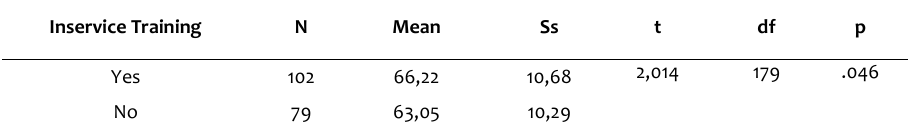
Table 9. Independent groups t-test table based on teachers' attitude scale according to the variable of in- service training on